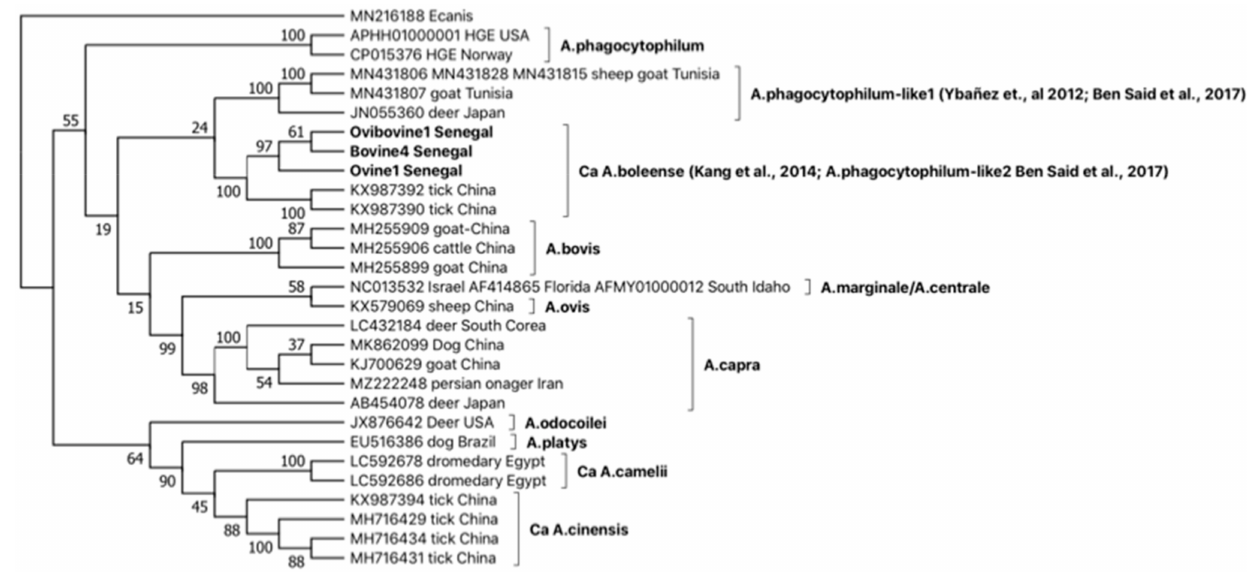
Figure 3. Phylogeny of groEL sequence types identified in Senegal genetically related to A. phago- cytophilum with OTUs selected as representative of the different Anaplasma species and Ehrlichia canis chosen as an outgroup. The bootstrap consensus tree inferred from 1000 replicates is taken to represent the evolutionary history of the taxa analyzed. The percentage of replicate trees in which the associated taxa clustered together is shown next to the branches. This analysis involved 29 nucleotide sequence types, and there were a total of 667 positions in the final dataset. References in clades are: A. phagocytophilum -like1 [17,23], Ca A. boleense